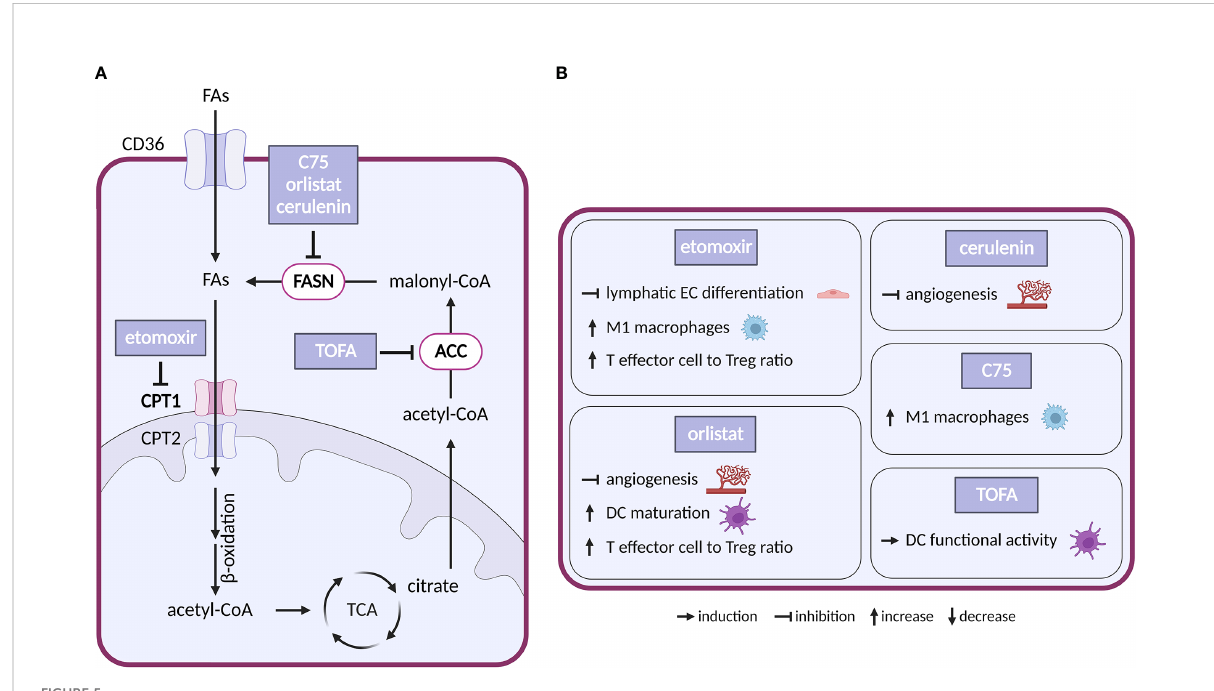
FIGURE 5 Inhibitors of fatty acid metabolism and their effects on TME cell types. (A) Schematic representation of FA metabolism. Only inhibitors with a reported effect in the TME are shown. Note that none of these inhibitors entered clinical trial in cancer. (B) Effect of the inhibitors shown in (A) on cell populations present in the